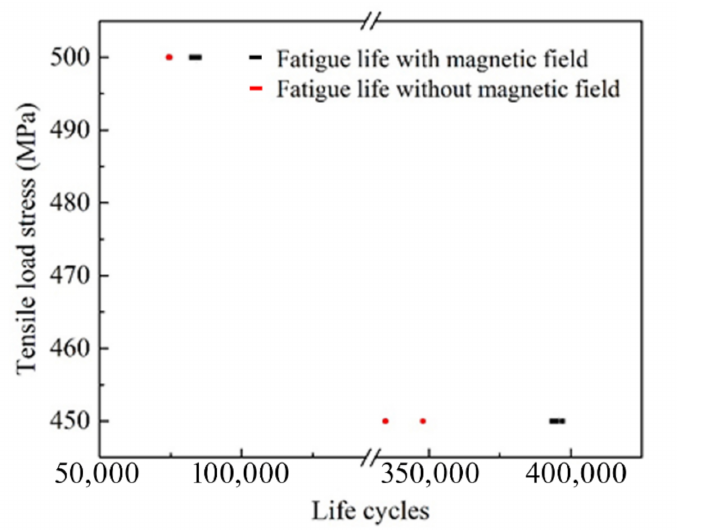
Figure 2. The fatigue life cycle under the load of 450 MPa and 500 MPa, with and without magnetic field. The tensile properties of 35CrMo steel after the fatigue tests for different life cycles are also influenced by magnetic field, although the increment of strength is small. The stress–strain curves obtained in the specimens cut from the fatigue samples (as shown in Figure 1) that have experienced different fatigue life cycles with and without magnetic field are shown in Figure 3a–c, suggesting that the strength of this material is increased by the magnetic field. The variation of yield strength of 35CrMo steel after the fatigue treatment for different life cycles tested with and without magnetic field are compared in Figure 3d. A small increment of yield strength under fatigue life cycles of 10,000, 50,000, and 100,000 times is caused by the magnetic field, with only the enhancement of 5–8 MPa of yield strength observed in Figure 3a–d. The numerical values on the longitudinal coordinates of Figure 3 are partially illustrated to show the small difference of stress and strength with and without magnetic field. It is similar to the previous reports [16–18] that the strength is enhanced by the magnetic field which can cause the pinning effect of magnetic domain wall on dislocations. This mechanism is discussed in the next